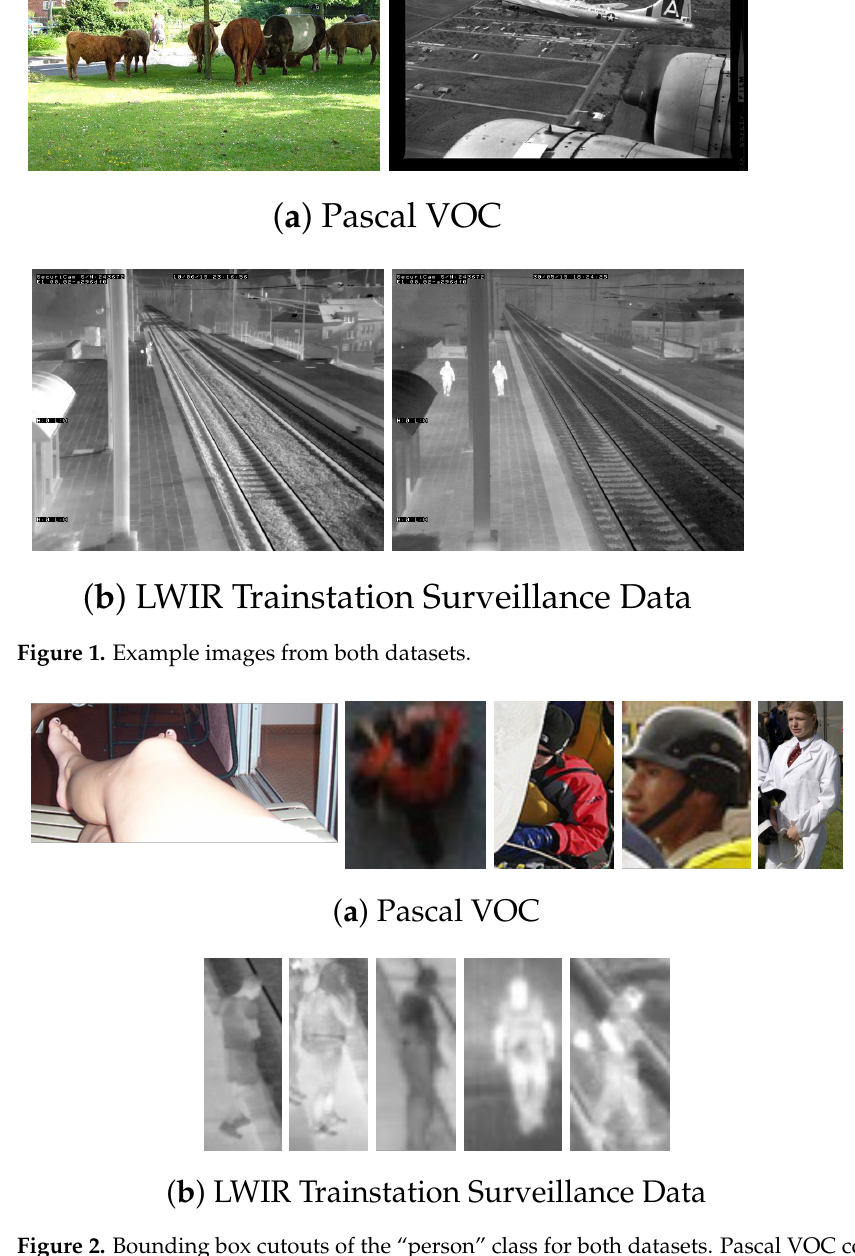
Figure 2. Bounding box cutouts of the "person" class for both datasets. Pascal VOC contains a lot of intra-class variance, whilst persons in the Long Wave Infrared (LWIR) dataset have a similar look. Table 2. LWIR video sequence in each split. Note that there is no sequence 2 available in the dataset.